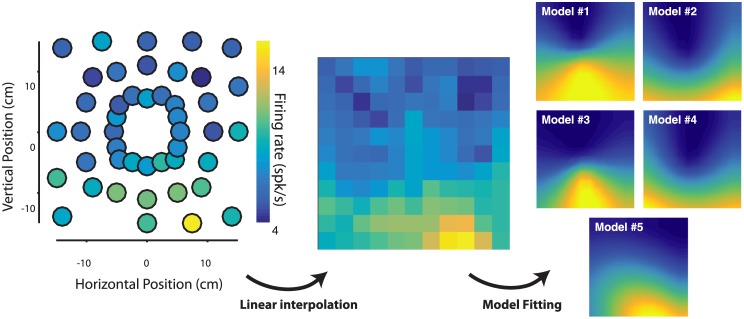
Response field characterization and modeling.For an example PMd neuron, the response field characterization procedure is shown. Color scale indicates firing rate response. The mean firing rate response to each reach target (left panel) is used to interpolate the two-dimensional spatial response pattern (middle panel). This interpolated response pattern is then used to fit computational encoding models of neuronal responses. Model response patterns for each of the tested models (corresponding to models 1–5) are shown below.